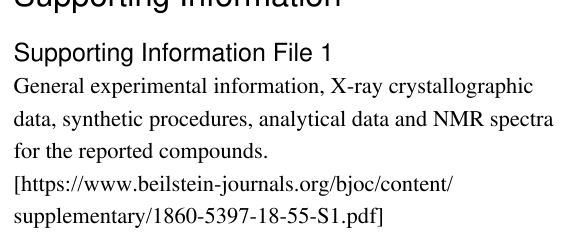
intermediate B which turns into indene C as the result of a 1,5- suprafacial hydrogen shift. Indene C can either convert into the final indene 3a via a slow 1,3-migration of the hydrogen atom, or is intercepted by carbene A with the formation of cyclo- propane D . The relative rates of these competing processes likely determine the composition of the final product